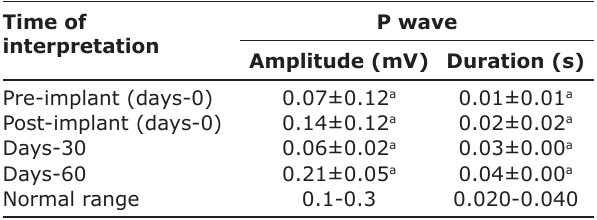
Same superscripts (a) in the same column indicate no significant differences of the PR intervals from different time of interpretation (p<0.05) Table-7: The average amplitude and duration of P wave of the pigs.